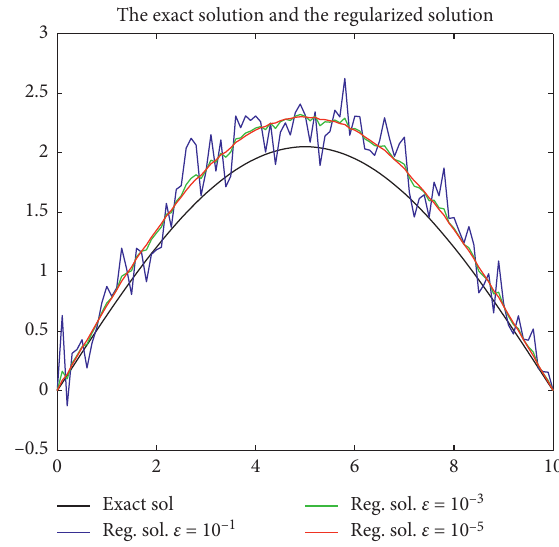
Figure 5: The graphs of u ( t ) and u ε , c ( t ) .